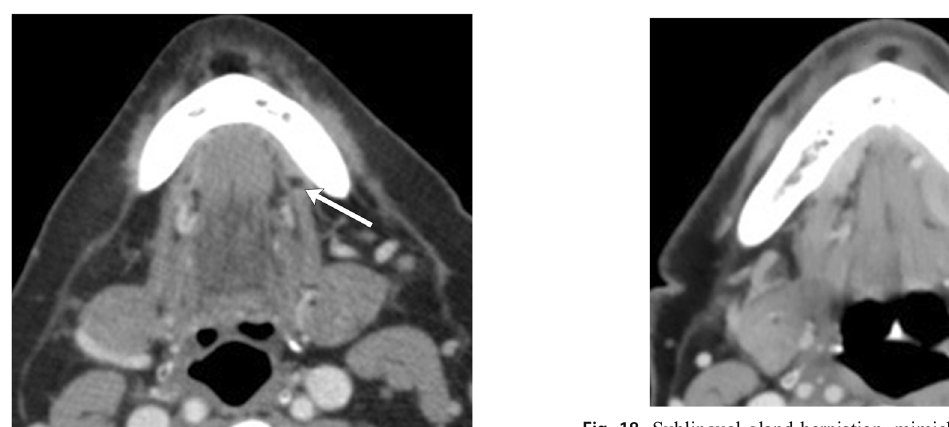
Fig. 16 Adenoid cystic carcinoma of the sublingual gland. a Axial T2- weighted and b T1-weighted MR images of the sublingual space demonstrate a lobulated high T2 signal and low T1 signal lesion